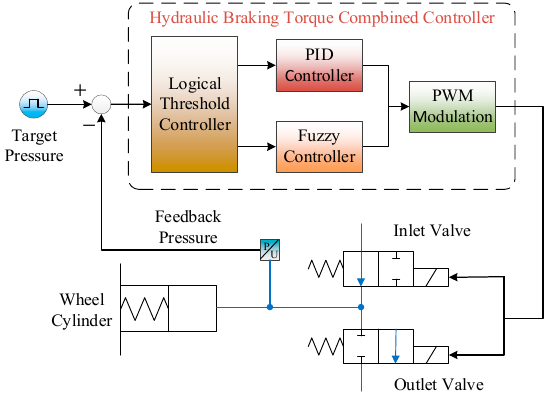
Figure 5. The pressure control algorithm of the wheel cylinder.